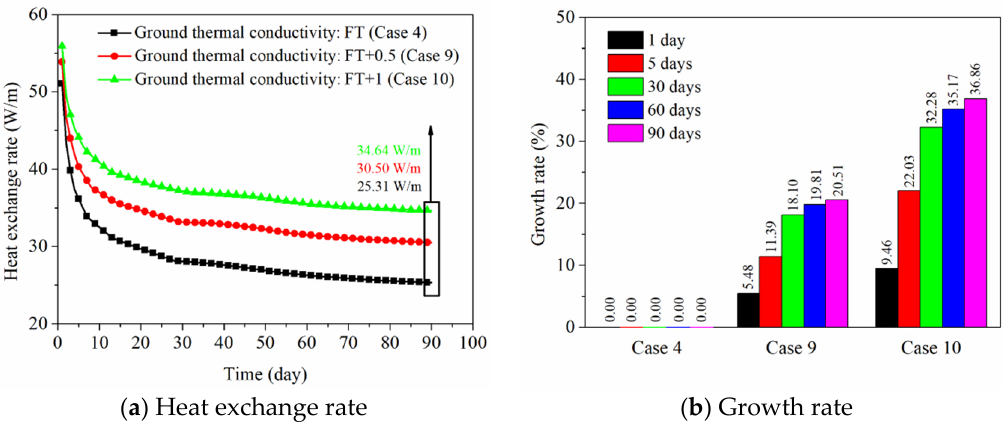
Figure 17. Effect of thermal conductivity of the ground on the thermal performance of energy pile.